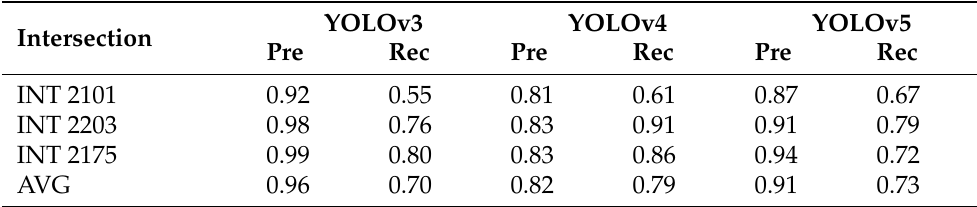
Table 1. Detection system evaluation for intersection monitoring (Pre: precision, Rec: recall).